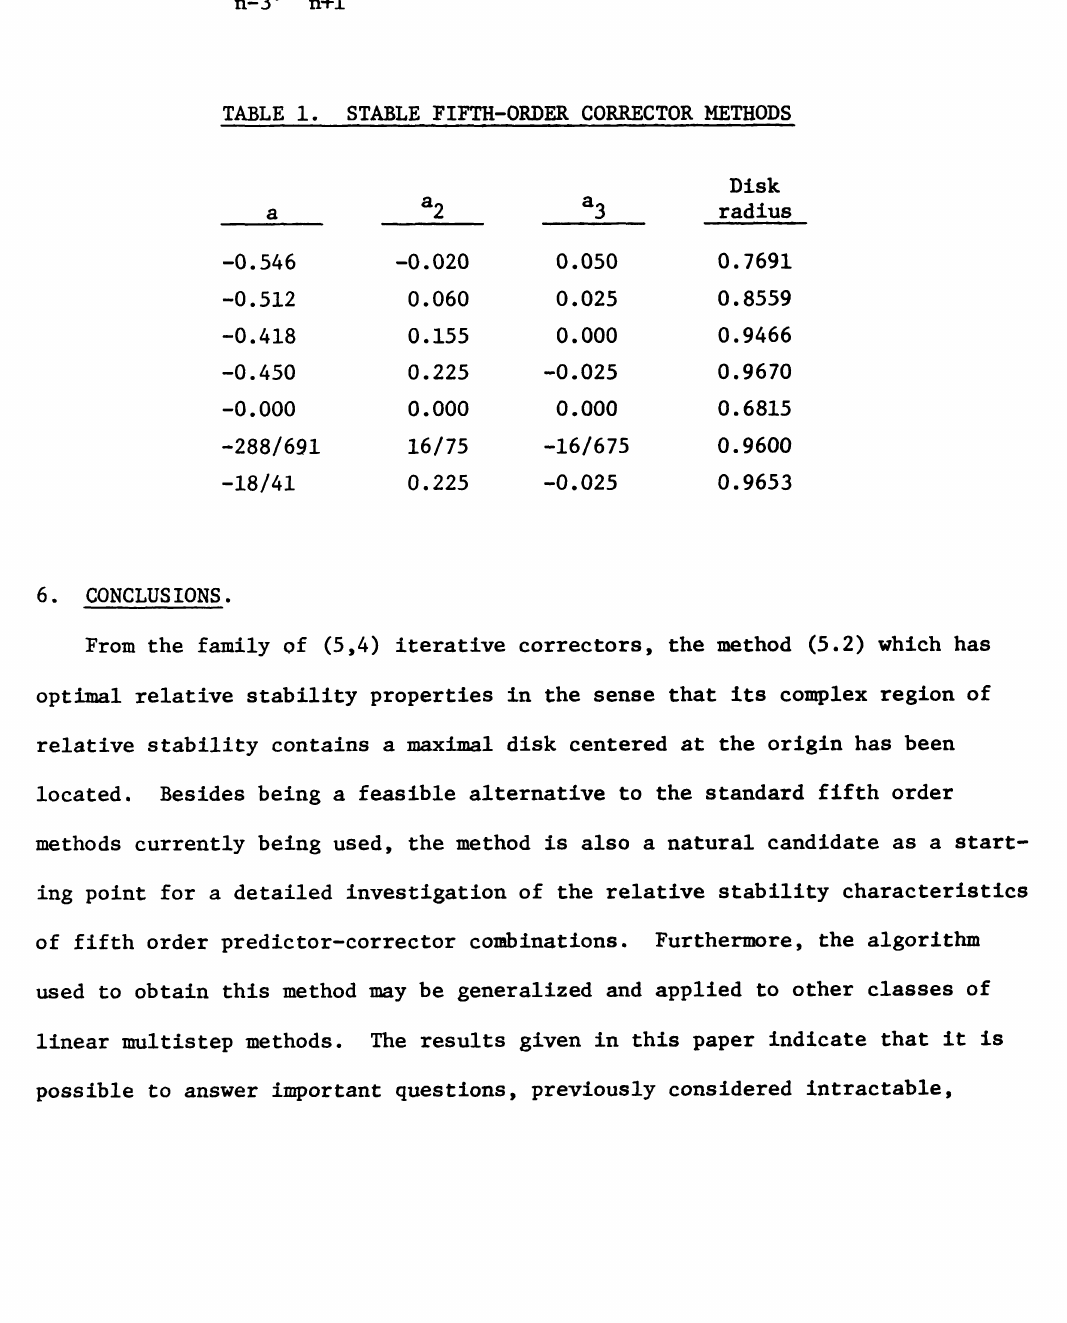
TABLE i. STABLE FIFTH-ORDER CORRECTOR METHODS